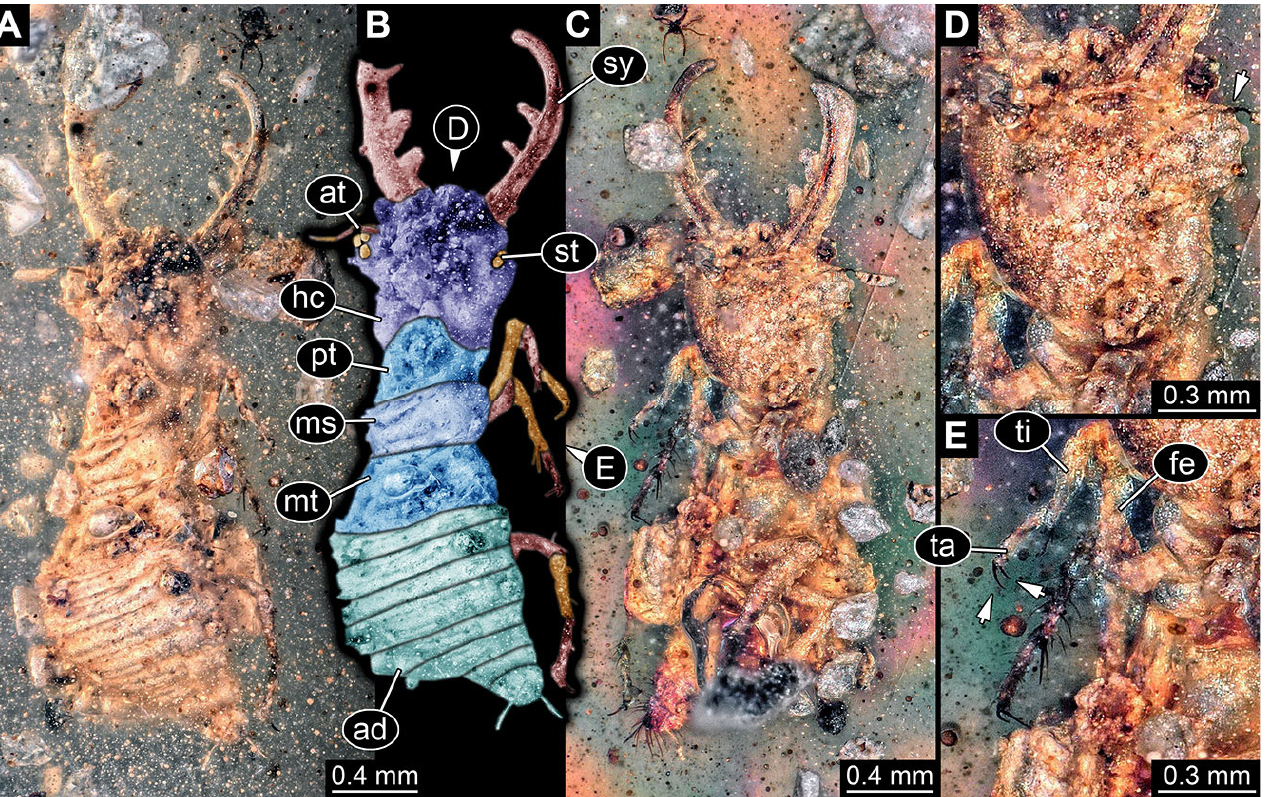
Figure 11. Fossil owllion larva, specimen 3223 (BUB 3063), Cretaceous Kachin amber, Myanmar. ( A ) Overview, dorsal. ( B ) Color-marked version of ( A ). ( C ) Overview, ventral. ( D ) Close-up on head capsule with field of stemmata (arrow). ( E ) Close-up on anterior trunk with locomotory appendages with claws (arrows). Abbreviations: ad = abdomen; at = antenna; fe = femur; hc = head capsule; ms = mesothorax; mt = metathorax; pt = prothorax; st = stemmata; sy = stylet; ta = tarsus; ti = tibia.